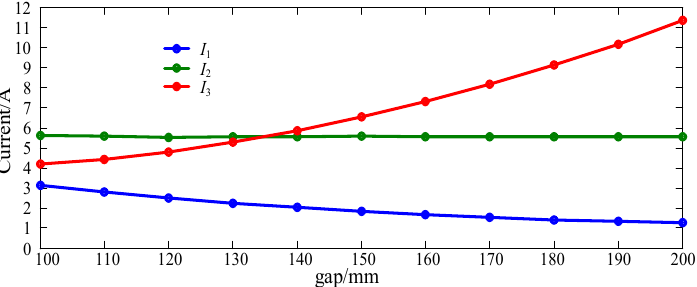
Figure 12. Current Versus Transfer Distance for 3-coil System.